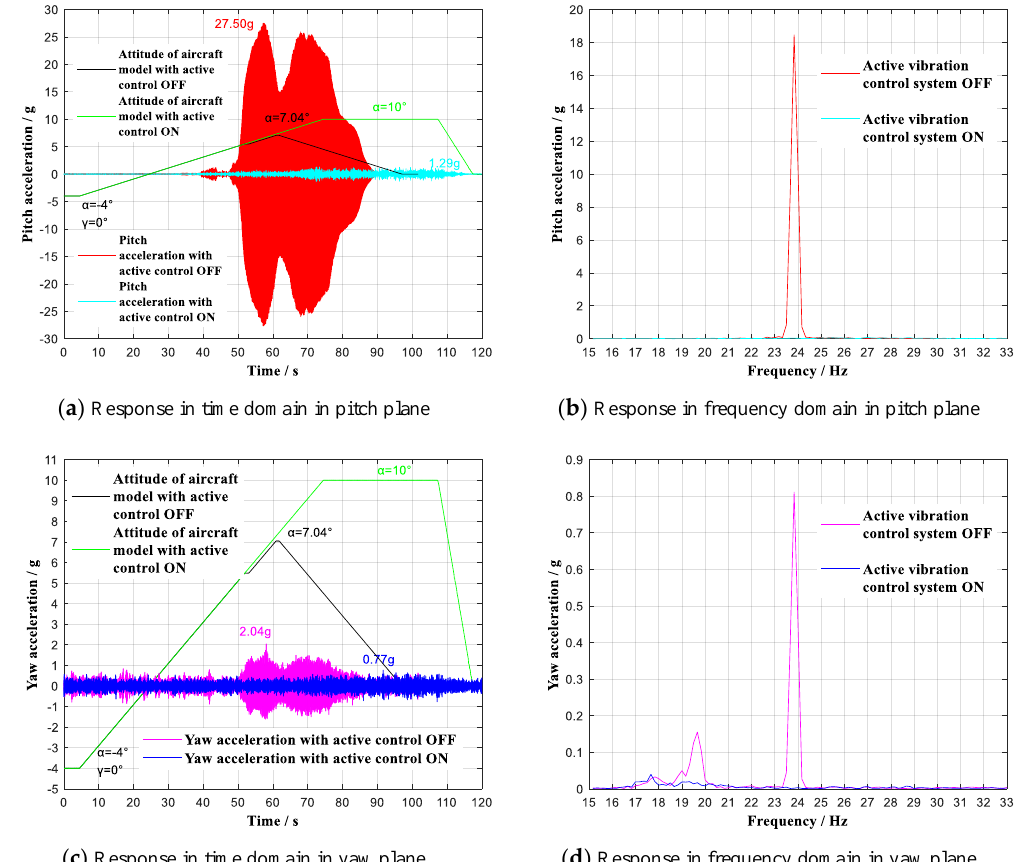
Figure 12. Vibration with multidimensional vibration suppression system on and off lifting continuous ( γ = 0°) at 0.7 Ma. ( a ) Response in time domain in pitch plane; ( b ) Response in frequency domain in pitch plane; ( c ) Response in time domain in yaw plane; ( d ) Response in frequency domain in yaw plane.